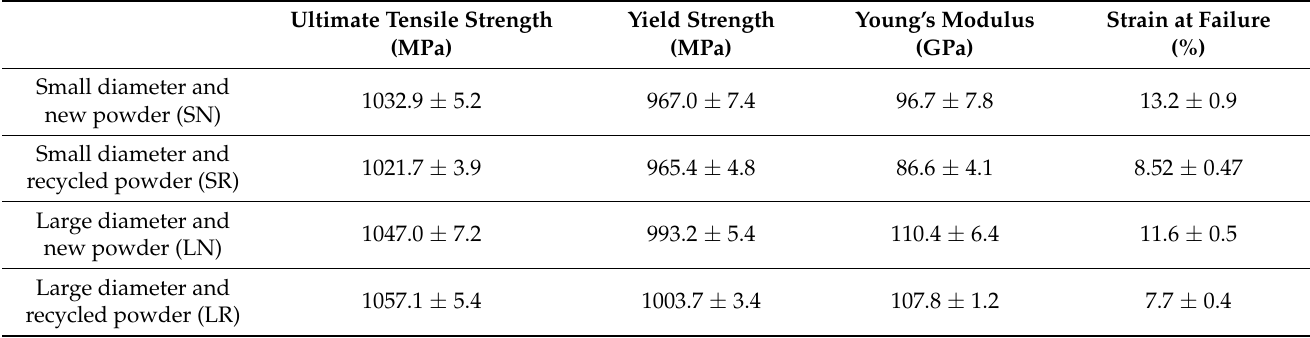
Figure 6. Comparison of tensile test results of 5-mm-diameter LPBF Ti-6Al-4V specimens fabricated with new and recycled powder. with new and recycled powder. Table 1. Mechanical properties of the LPBF Ti-6Al-4V specimens, given as the mean ± standard